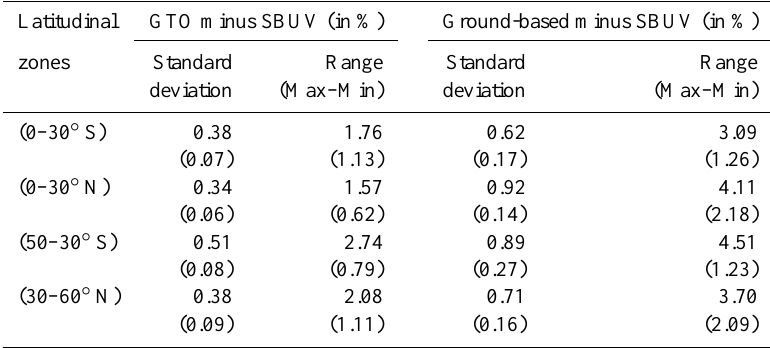
Table 7. Summary of the differences in seasonal zonal mean anomaly (four broad latitudinal zones). Latitudinal GTO minus SBUV (in %) Ground-based minus SBUV (in %) zones Standard Range Standard Range deviation deviation